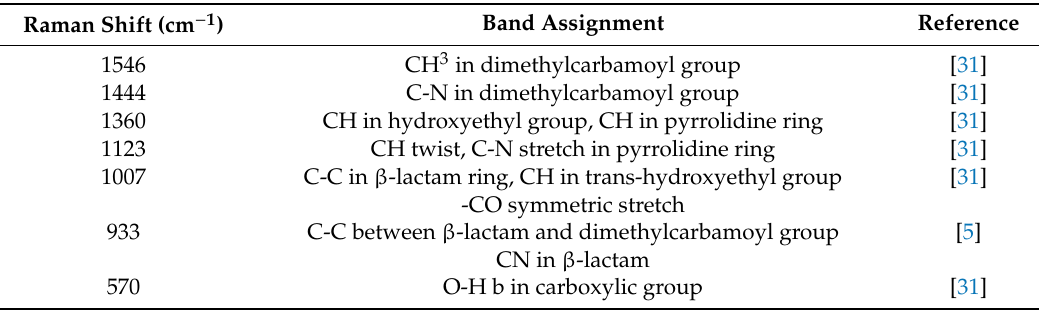
Table 1. Band assignment of the SERS modes of MPN.